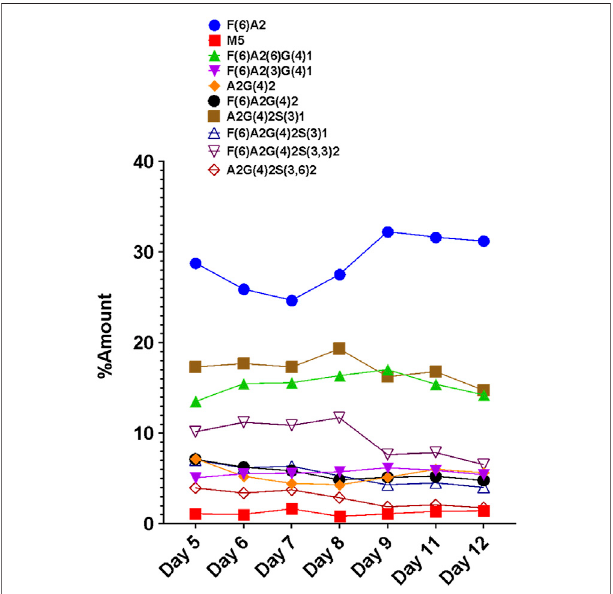
FIGURE 4 | Day-wise evolution of various glycan species of the VRC01 mAb expressed using A11 CHO cell line in fed-batch culture.